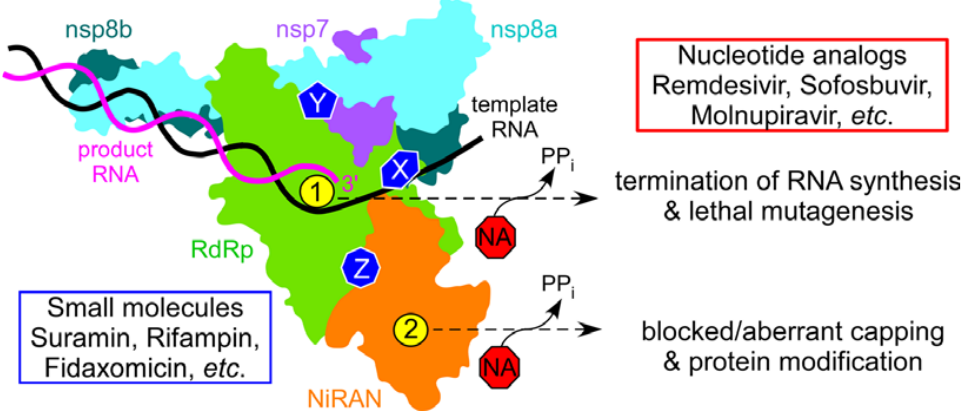
Figure 1. SARS-CoV-2 RdRp holoenzyme is composed of the catalytic nsp12 and accessory nsp7 and nsp8 (present in two copies) subunits. Nsp12 has two active sites, in the RdRp (green) and NiRAN (orange) domains, shown by yellow circles marked as 1 (AS1) and 2 (AS2); the same colors are used throughout the manuscript. The RNA synthesis active site, AS1, is structurally conserved among viral RdRps. NiRAN mediates NMP transfer to viral proteins and to RNA at AS2, which is homologous to AMPylases. Both active sites use diverse NAs as substrates, and the consequences of nucleotide misincorporation vary dependent on the NA. The holoenzyme presents many hypothetical targets for small-molecule inhibitors (X, Y, and Z), which may block RNA binding, interfere with nsp12 contacts to the accessory subunits, or disrupt allosteric communications between the two active sites. Suramin has been shown to bind to two separate sites on nsp12 and inhibit RNA binding. Here, we report that fidaxomicin and rifabutin, natural products in clinical use as antibiotics, inhibit RNA synthesis but not RNA binding; their binding sites and mechanisms of action remain to be identified.